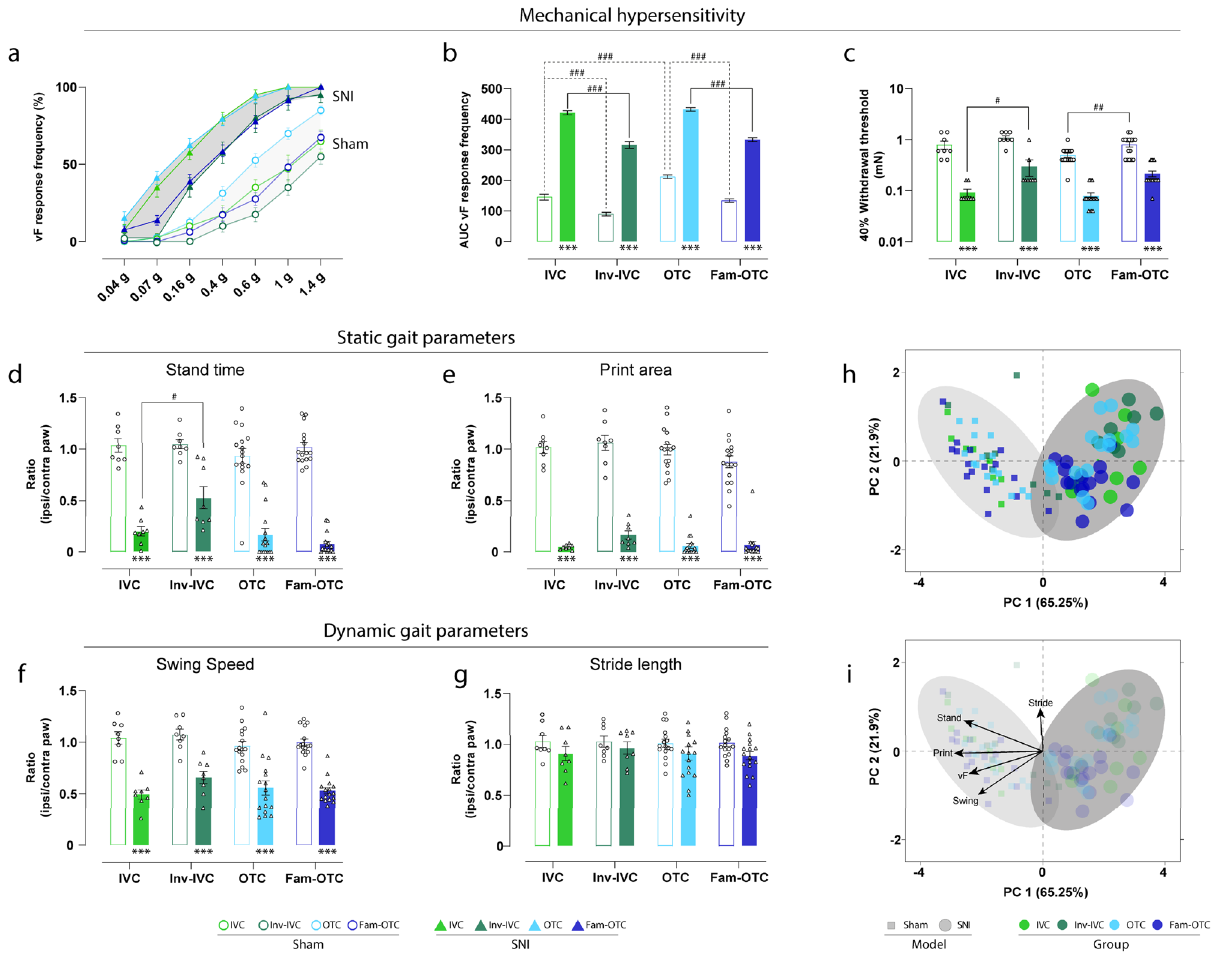
Figure 1. Pain-related phenotype of peripheral neuropathy is affected by experimenter familiarization and an inverted day-night cycle. ( a ) The response frequency in % for each von Frey (vF) filament, ( b ) the Area under the curve (AUC) of the frequency response curves and ( c ) the 40% response threshold in all experimental groups showed a mechanical hypersensitivity in spared nerve injury (SNI) compared to sham mice under the different housing conditions. ( d – g ) Due to peripheral neuropathy, static and dynamic parameters were significantly modulated within the gait analysis compared to sham. An exception is the stride length, which was not changed. ( h , i ) Through the multivariate analysis of pain-associated parameters, a distinct phenotype of peripheral neuropathy (SNI) was found, which is characterized by mechanical hypersensitivity (reduction of mechanical threshold), and an antalgic gait pattern (reduction of stand time, print area, and swing time). Results are expressed as mean ± SEM. N = 8 for all individually ventilated cage (IVC) and inverted (Inv) day-night cycle in IVC (Inv-IVC) groups and N = 16 for all open top cages (OTC) without or with experimenter familiarization (Fam-OTC) groups. Two-way ANOVA (repeated measures based on GLM) followed by Dunnett’s multiple comparison test. *For comparison to sham; p values: * ≤ 0.05, ** ≤ 0.01, *** ≤ 0.001. # For comparison to husbandry conditions; p values: # ≤ 0.05, ## ≤ 0.01, ### ≤ 0.001. The Principle components (PC) were selected to determine the eigenvalues. MANOVA was used for cluster analysis in PCA (see Table